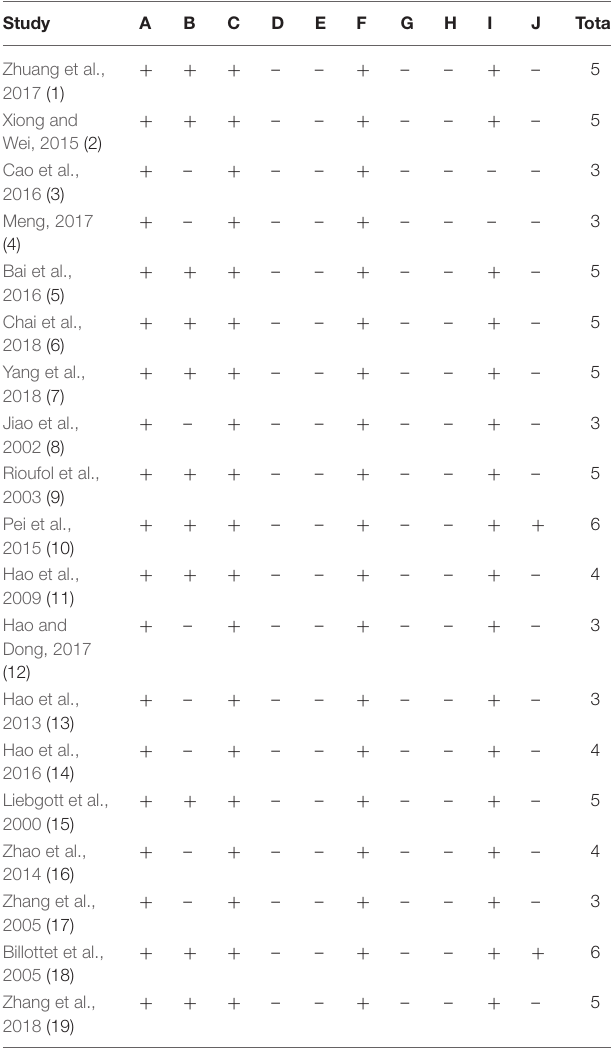
TABLE 2 | Risk of bias of the included